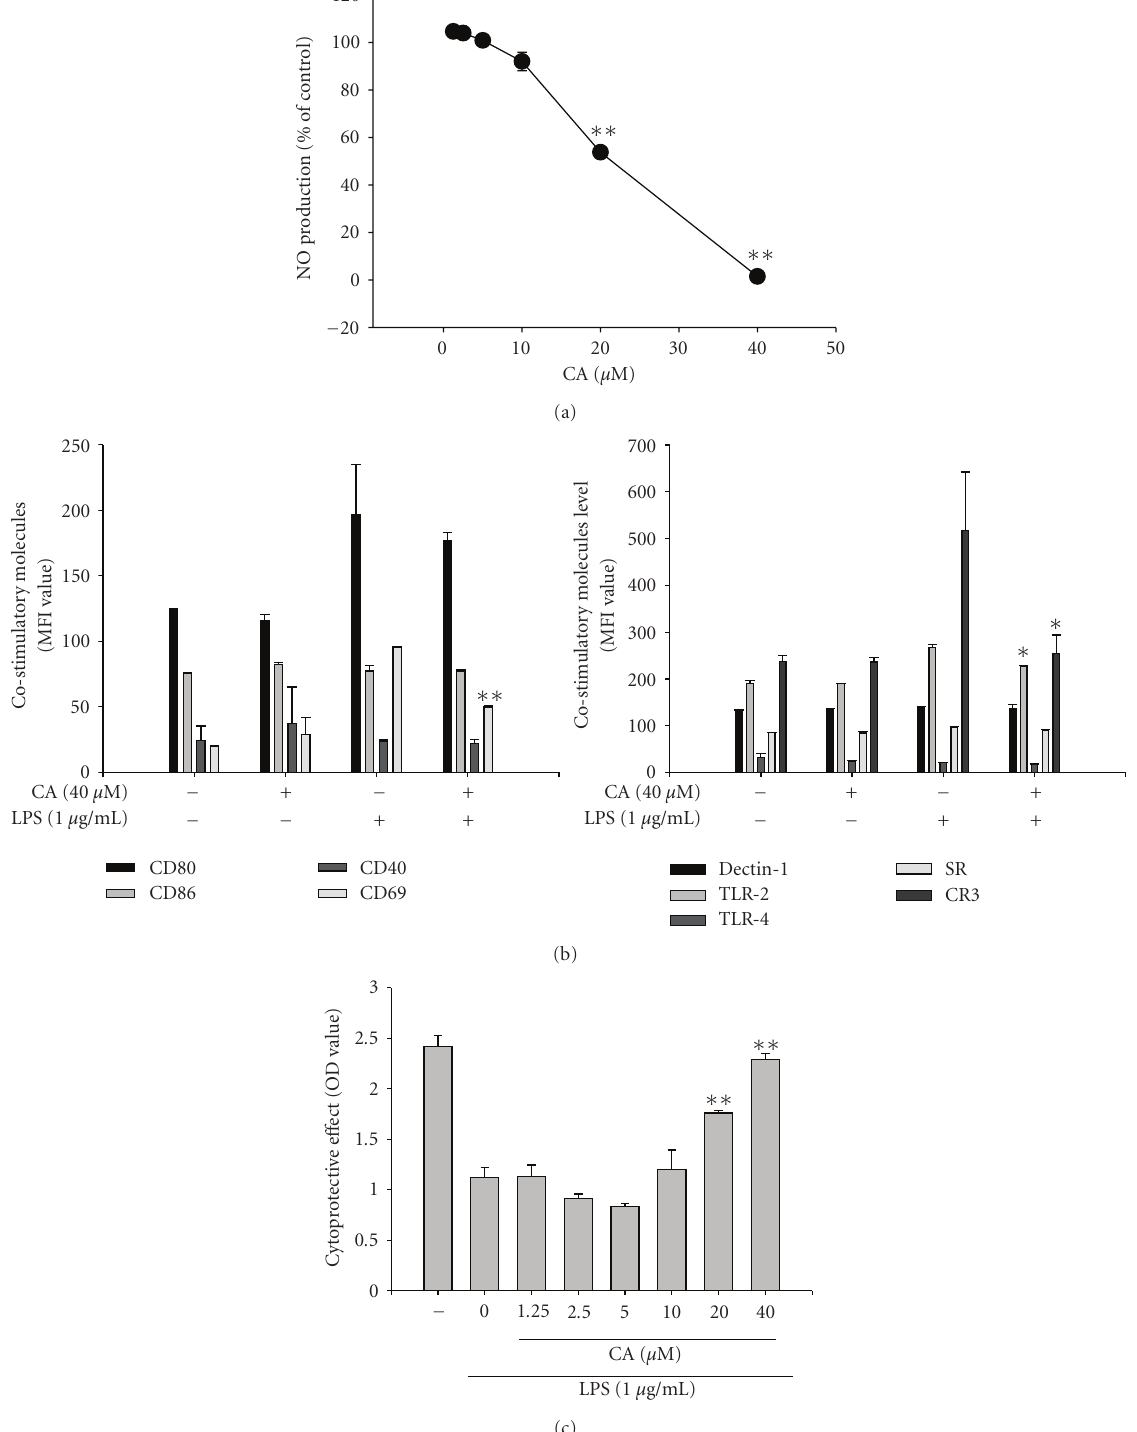
Figure 2: E ff ect of CA on the production of NO and surface upregulation of costimulatory molecules and pattern recognition receptors in LPS-activated RAW264.7 cells. RAW264.7 cells (2 × 10 6 cells/ml) were incubated with concentrations of CA in the presence of LPS (1 μ g/ml) for 24h (NO), 12h (costimulatory molecules and pattern recognition receptors), or 24 h (cytoprotective e ff ect). NO levels (a) in culture supernatant were determined by Griess assay. Surface levels of CD40, CD69, CD80, CD86, dectin-1, TLR2, TLR4, SR, and CR3 were determined by flow cytometric analysis. The viability of RAW264.7 cells was determined by MTT assay. ∗ P < . 05 and ∗∗ P < . 01 represent significant di ff erence compared to LPS